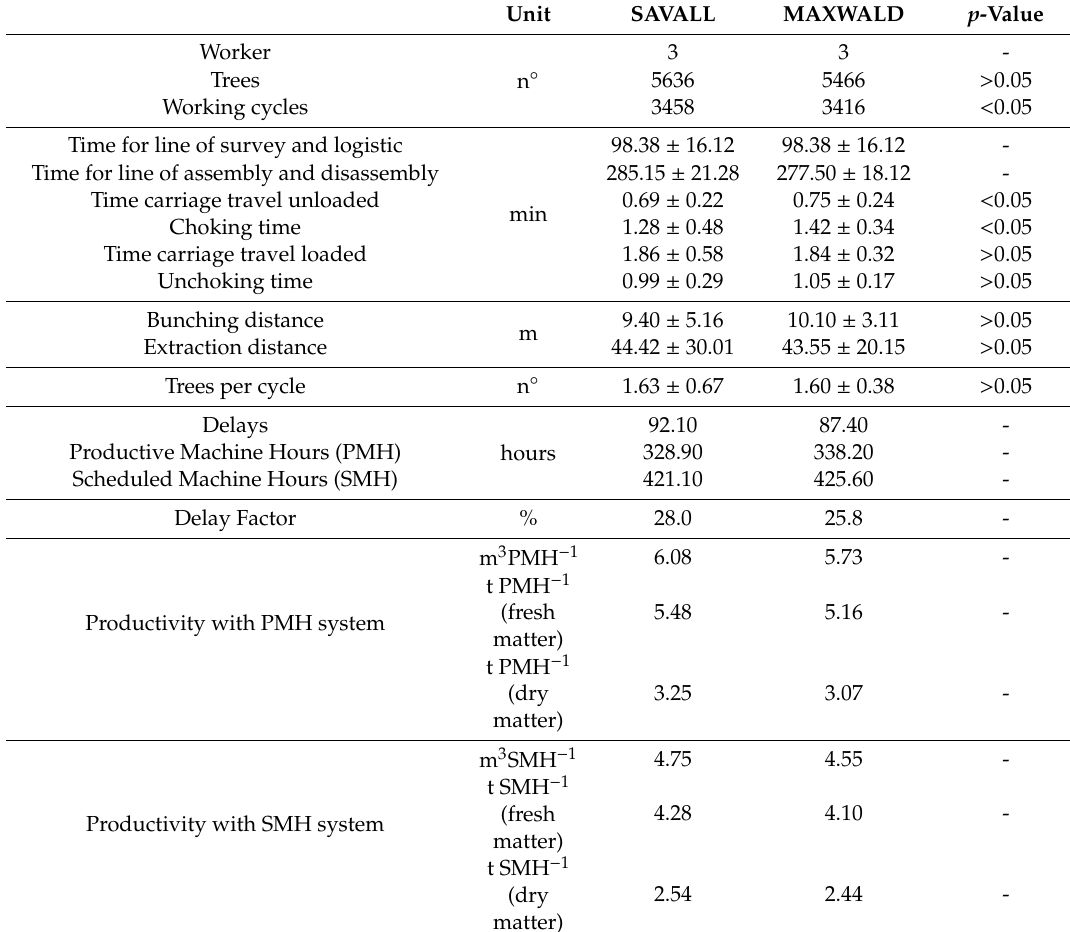
Table 7. Time and productivity of bunching—extraction operation (average ± standard deviation) in two logging systems, and results of MANOVA